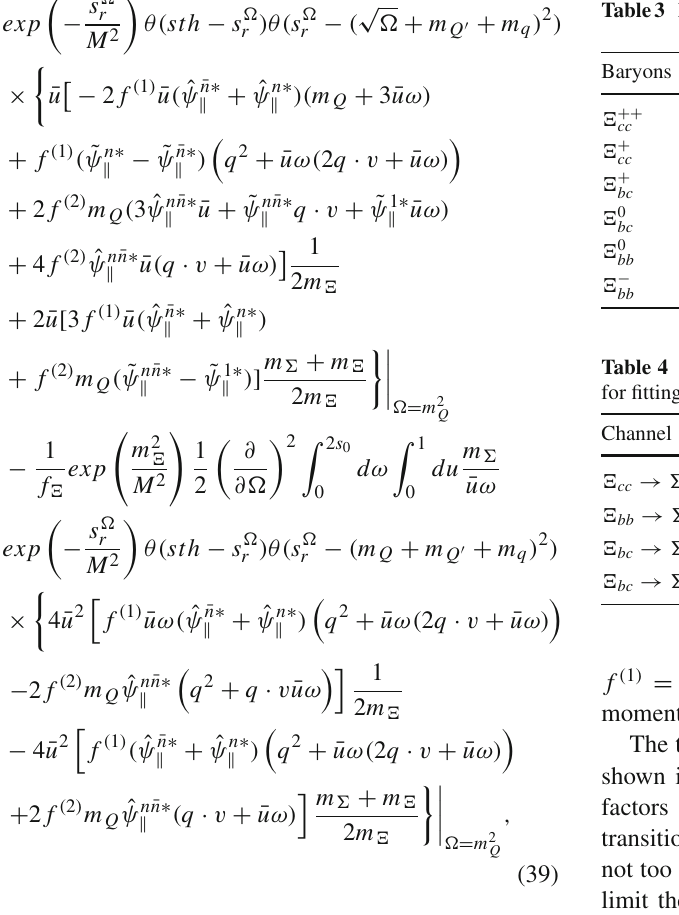
Table 4. The parameterization formula used in this work